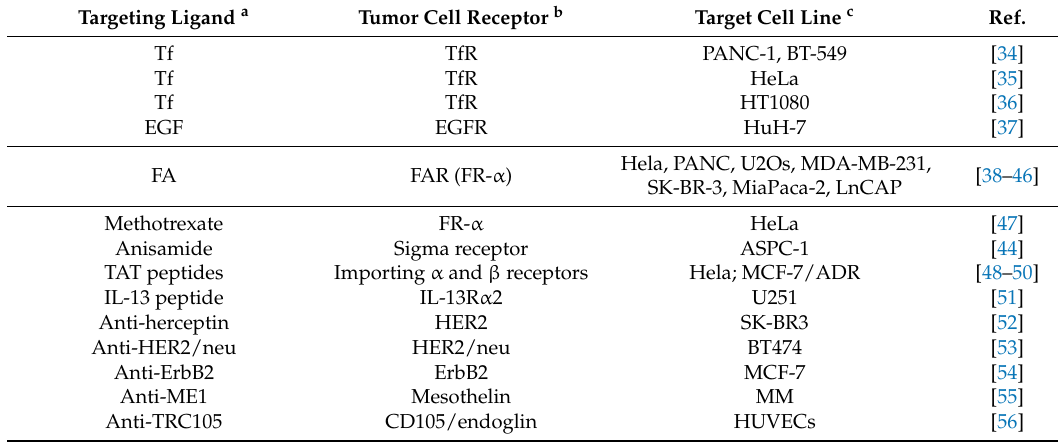
Table 1. Different active targeting strategies for MSNs.